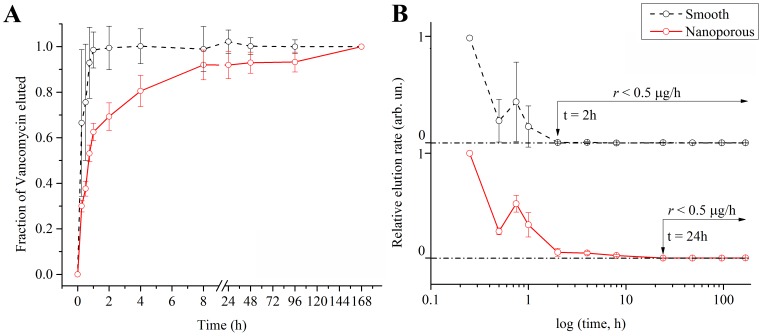
Point-by-point curves of the fraction eluted (A) and relative elution rate (B) of vancomycin adsorbed onto smooth (solid black line, n = 4) and nanoporous (solid red line, n = 4) surfaces.Dotted line in B represents the plateau of no significant elution (i.e. elution rate<0.5 μg/h). Data points are visualized as mean +/− standard deviation.